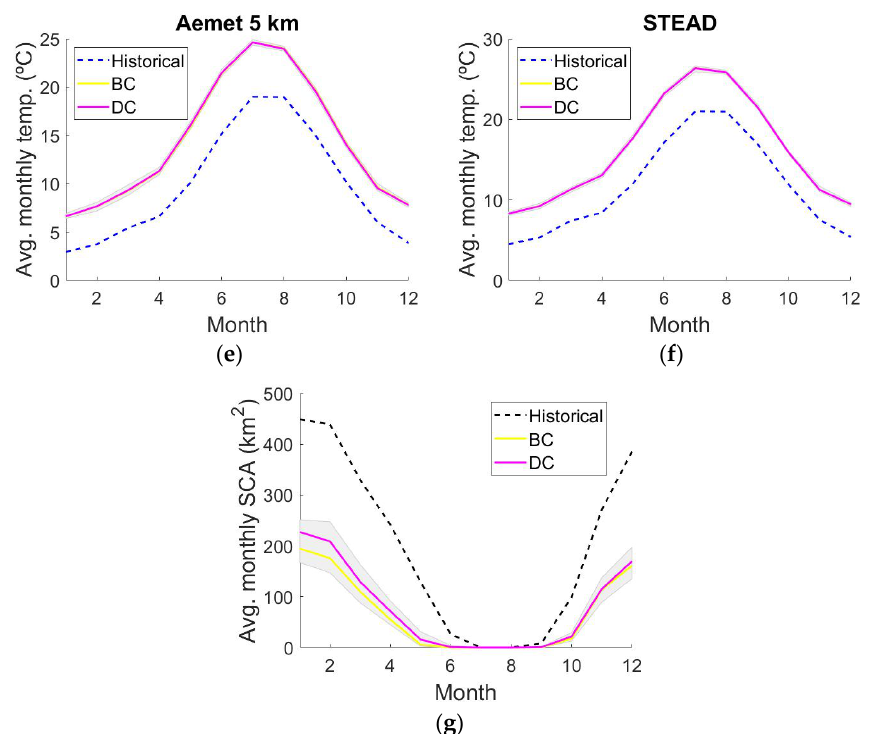
Figure 11. Historical and future average precipitation with uncertainty range for the ( a ) Spain02 database; ( b ) Aemet 5 km database; ( c ) SPREAD and STEAD database. Historical and future average temperature with uncertainty range for the ( d ) Spain02 database; ( e ) Aemet 5 km database; ( f ) SPREAD and STEAD database. Historical and future SCA with uncertainty range. Historical and future average snow cover with uncertainty range ( g ).